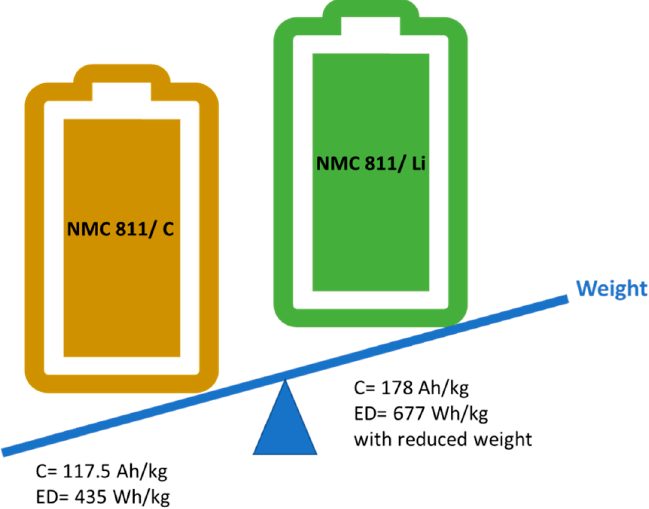
Figure 1. Illustration of graphite vs. Li-metal anode with combination of NMC 811 cathode.